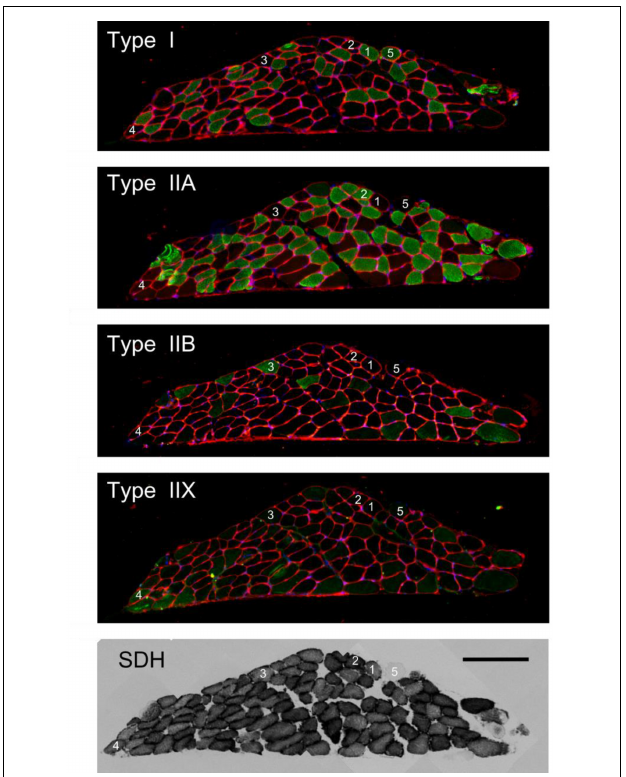
FIGURE 2 | Typical example of histochemically stained cross-sections of a muscle fiber bundle. Type of staining is indicated within each image. The bottom right scale bar serves all panels and represents 200 µ m. The numbered fibers 1–5 label Type I, IIA, IIB, IIX, and a fiber devoid of mitochondrial activity, respectively. Note that the fiber without mitochondrial activity (nr 5) is stained positive in the type I staining.